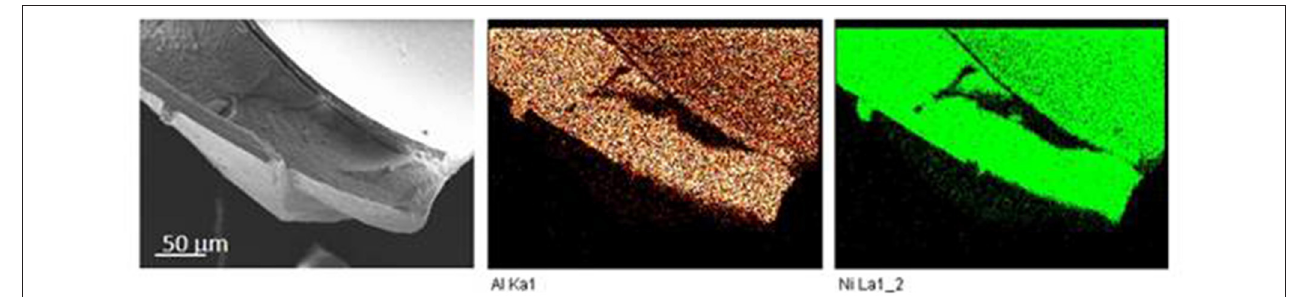
FIGURE 4 | Energy dispersive X-ray (EDX) mapping analysis of NiAl@Alg-Ca.